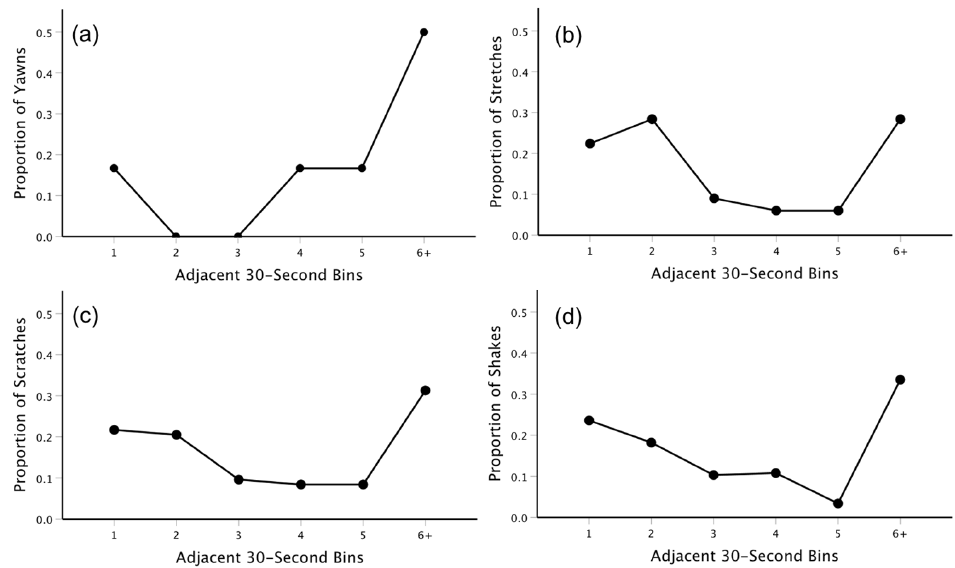
Figure 3. The proportion of yawns ( a ), stretches ( b ), scratches ( c ), and shakes ( d ) that occurred within 30 s bins, ranging from 30- to >180-s, of the most recently performed matched behavior from a separate group member.